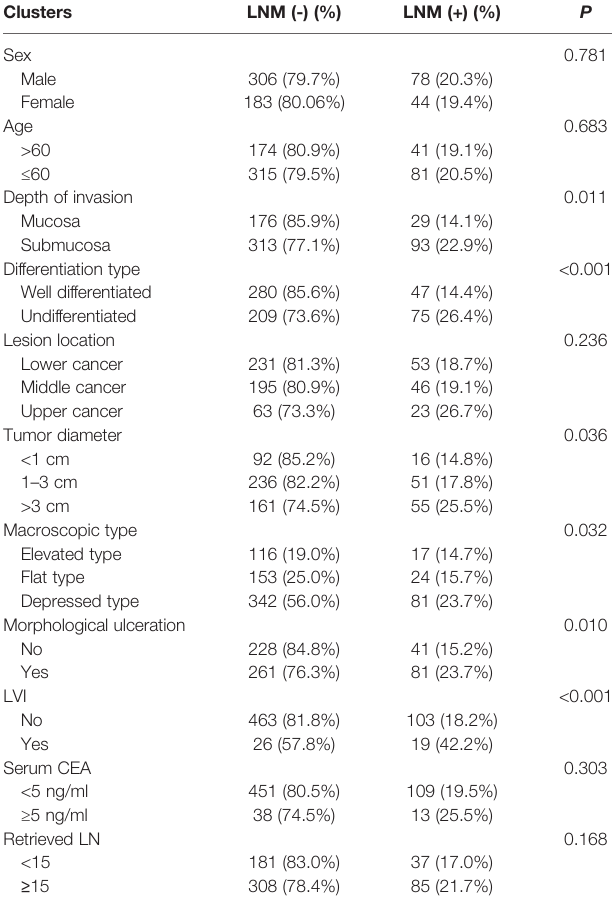
TABLE 2 | The relationship between clinicopathological characteristics and status of lymph node metastasis in EGC.